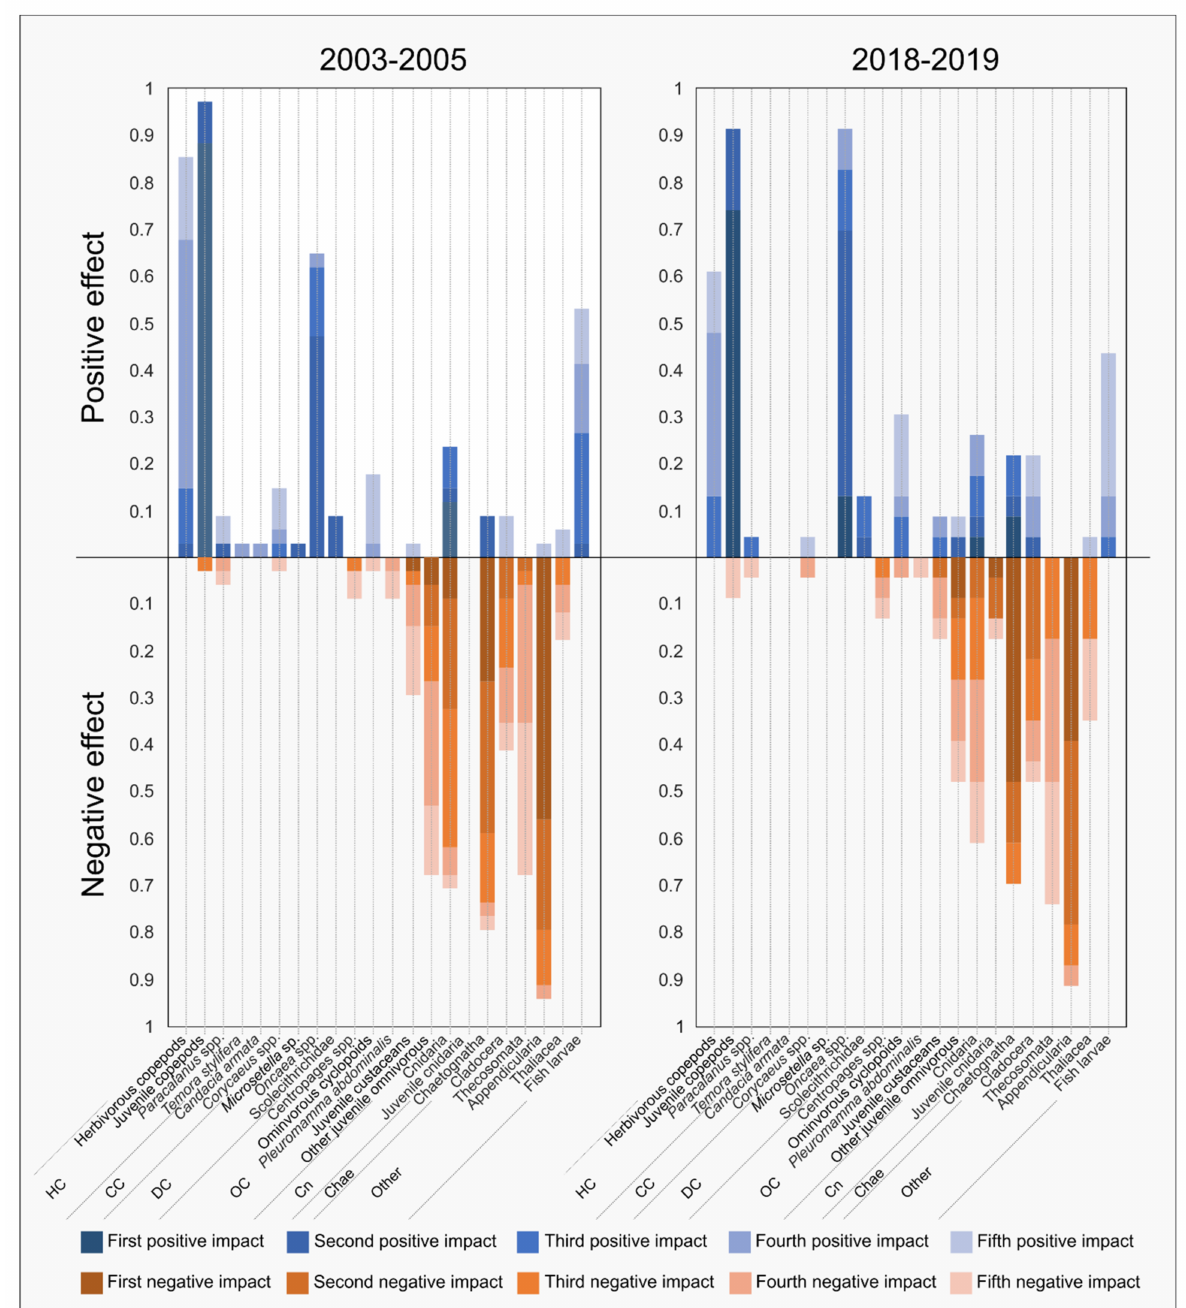
Figure 8. Positive and negative effects of considered functional group (values reported as frequency of appearance). Ascendency ranges from 8.16 to 55.47 mgC/m 3 /year averaging 26.23 ± 10.81 mgC/m 3 /year. Maximum values and highest variability are displayed in spring (Figure 9). Ascendency in the two years period 2018–2019 always displayed larger maximum, minimum and average values than